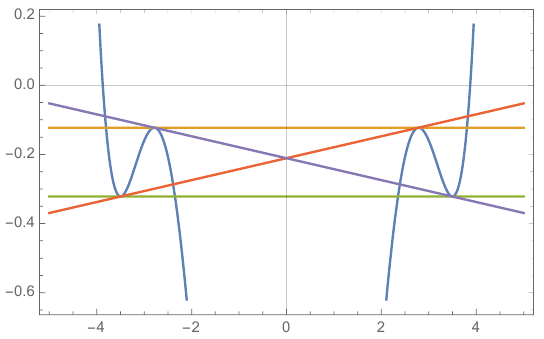
Figure 15 . 4 solutions under the condition 1 when g = − 1 / 15 . The blue line is the function D 1 ( x ) which is independent of moments W , whereas other color straight lines are different solution 1 , W 2 of D ( x ) . We see only the green line has the correct configuration of zeros depicted in figure 2